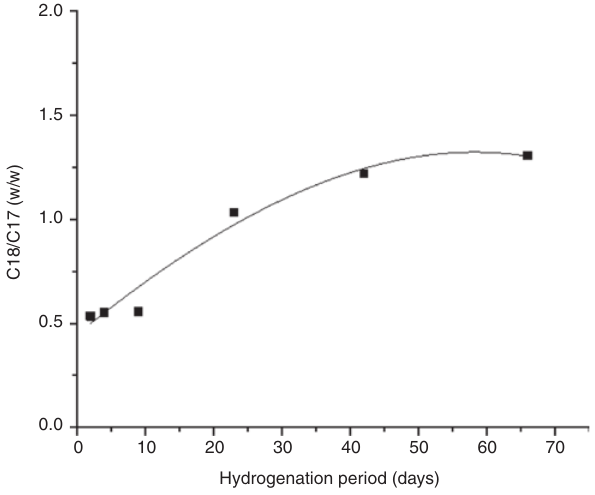
Figure 3: Amount of sulfur content versus hydroprocessed 10% fatty acid methyl ester (FAME) in light gas oil (LGO) for all conditions. Figure 2: C 18 /C 17 ratio versus hydrogenation period of 10% fatty